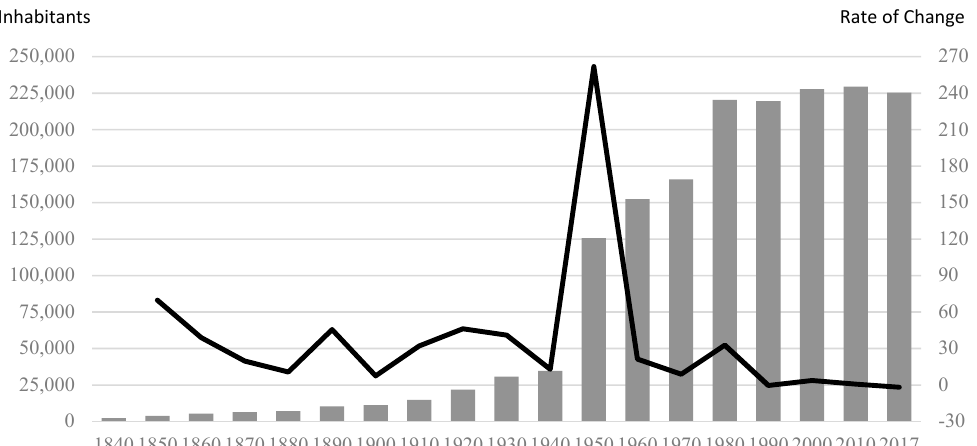
Figure 5. The population evolution of Baton Rouge and rate of change (own illustration according to [121]).